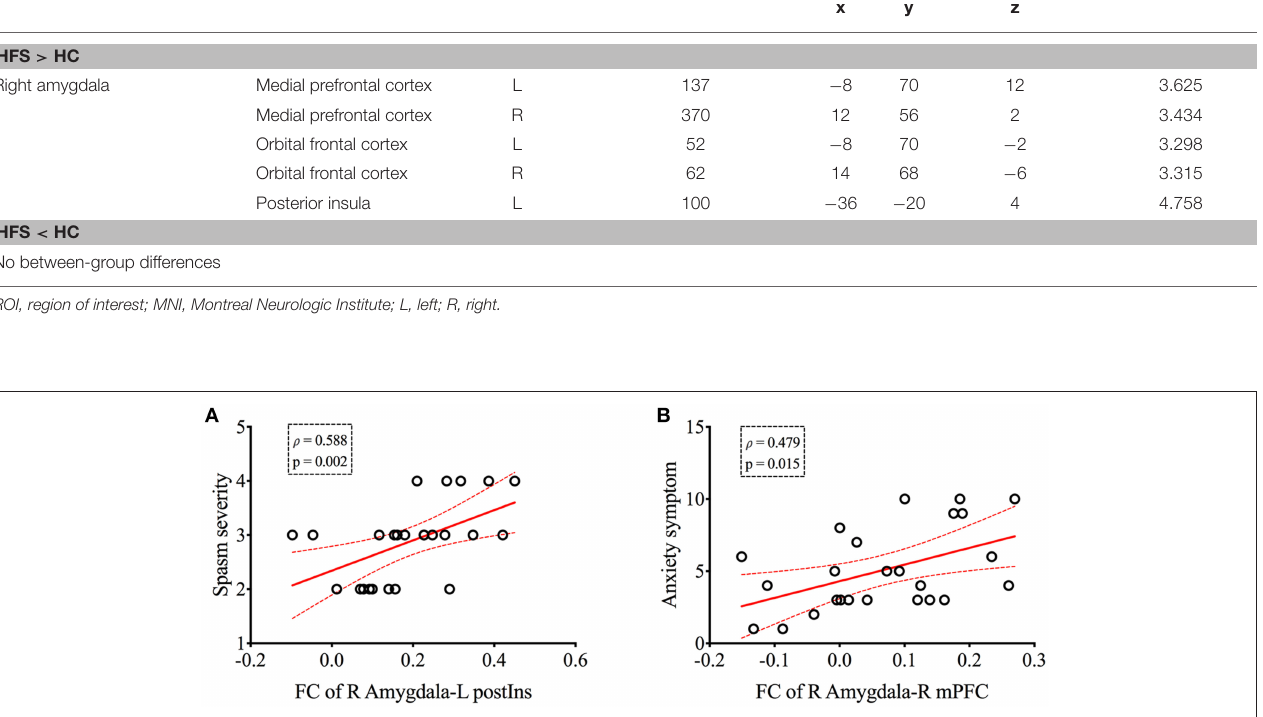
FIGURE 3 | The right amygdala-based functional connectivity was positively correlated with spasm severity (A) and anxiety symptom (B) in patients with HFS, respectively. Curved dashed lines indicate 95% confidence intervals. The spasm severity was measured by Cohen evaluation scale, and Hamilton Anxiety Scale was performed to assess patients’ anxiety symptom. FC, functional connectivity; postIns, posterior insula; mPFC, medial prefrontal cortex; L, left; R, right.